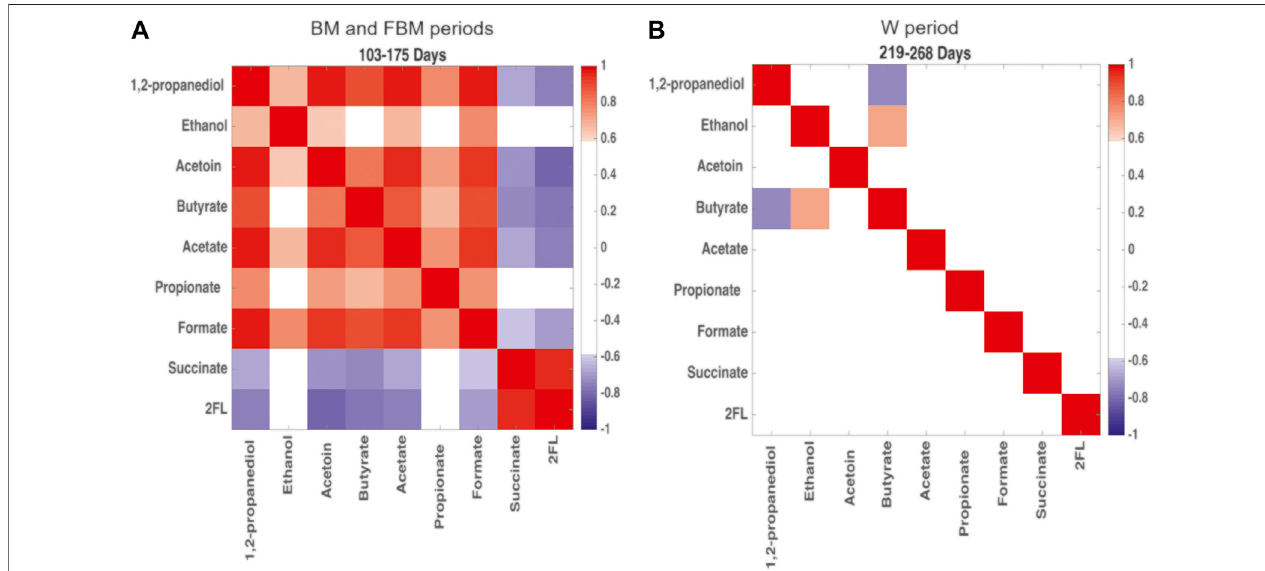
FIGURE 5 | Heatmap built from Pearson ’ s correlation coef fi cients for the microbial metabolic products of carbohydrate degradation. Comparison between (A) days 103 – 175, predominantly breastfeeding, and (B) days 219 – 268, predominantly solid food. Red: positive correlations; blue: negative correlations. Correlation coef fi cient > 0.6 and < − 0.6 are signi fi cant with p < 0.05.